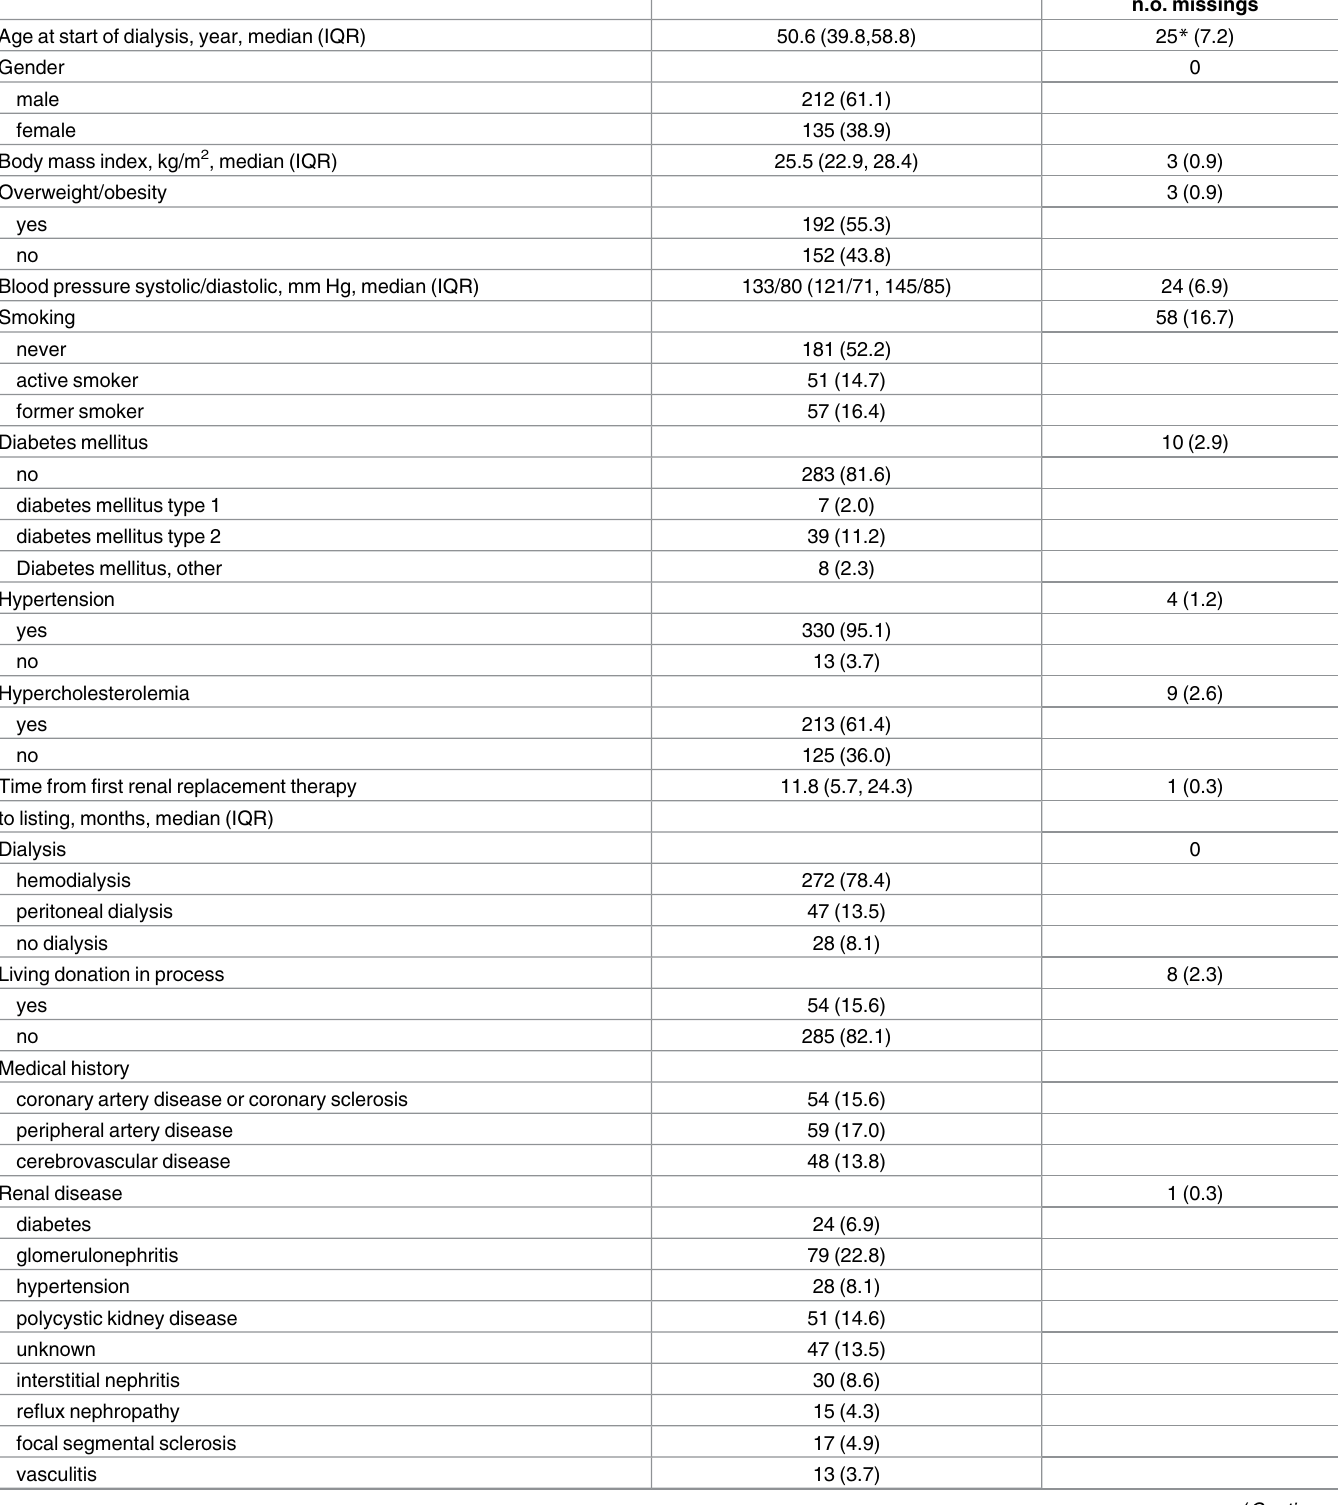
Table 1. Patients‘Demographic Characteristics (n =